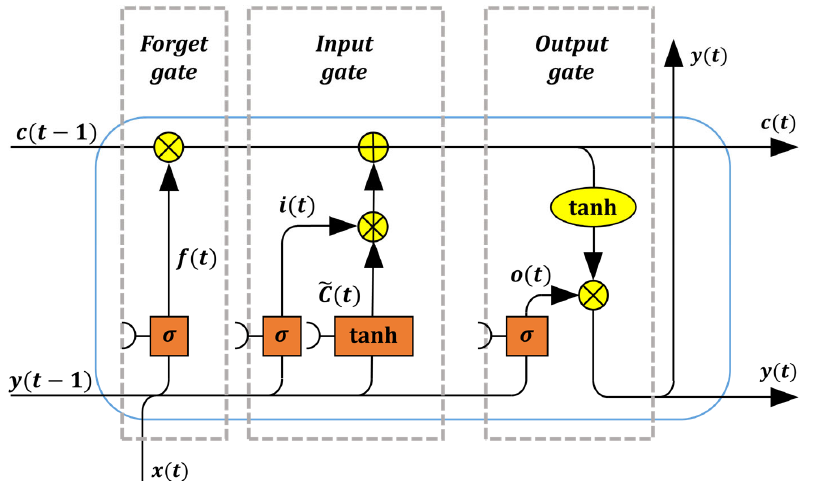
Fig. 3. Long short-term memory structure (modified from Yu et al.,